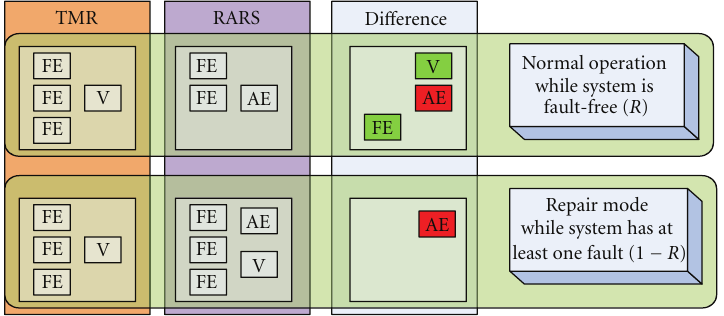
Figure 12: Component di ff erence between RARS and